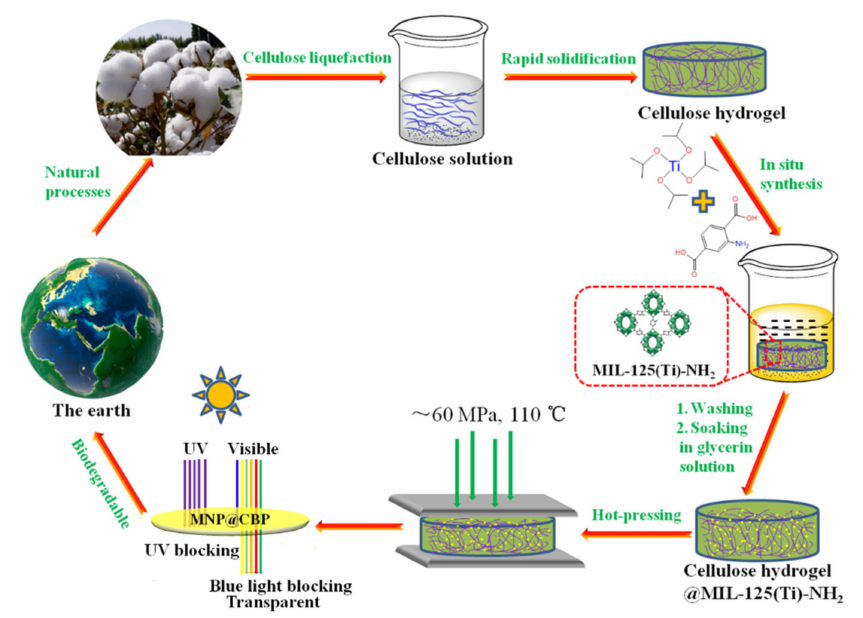
Figure 1. Schematic demonstration of the preparation process for